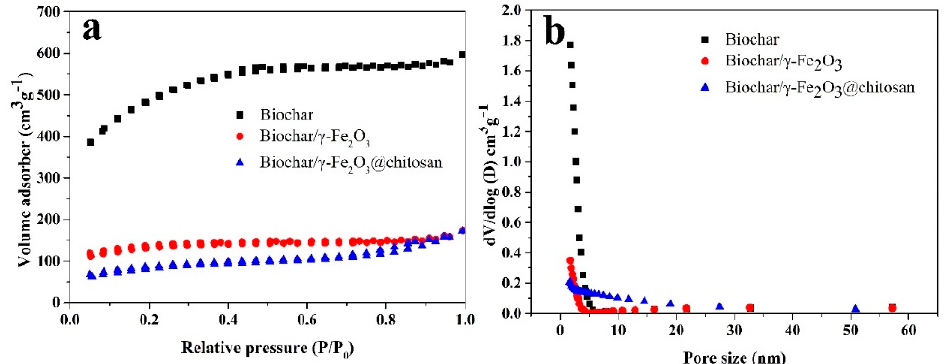
Figure 4. ( a ) The N 2 adsorption–desorption isotherm and the ( b ) pore size distribution of the porous biochar (black square), biochar / γ -Fe 2 O 3 (red ball), and biochar / γ -Fe 2 O 3 @chitosan (blue triangle) using the BJH method. Table 1. The average pore size, Brunauer–Emmett–Teller (BET) surface area, and total pore volume of the biochar, biochar / γ -Fe 2 O 3 , and biochar / γ -Fe 2 O 3 @chitosan.